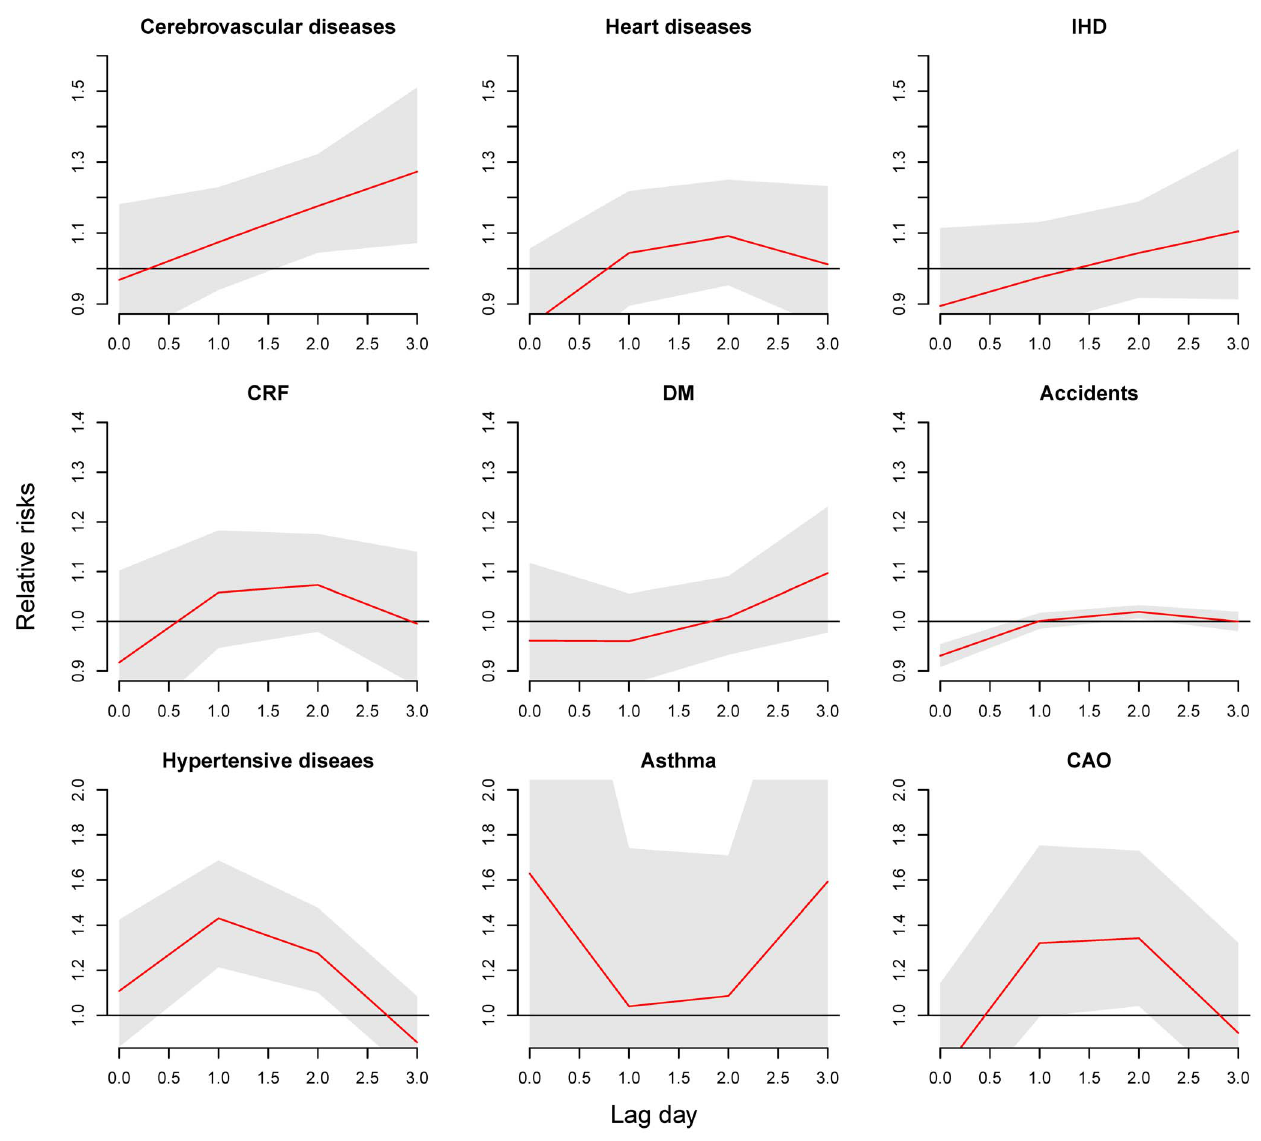
Figure 2. Lag effects of a temperature of 14 6 C on cause-specific emergency room visits compared to a centered temperature of 26 6 C for cerebrovascular diseases, 18 6 C for CRF, DM, and accidents, and 30 6 C for hypertensive diseases, asthma, and